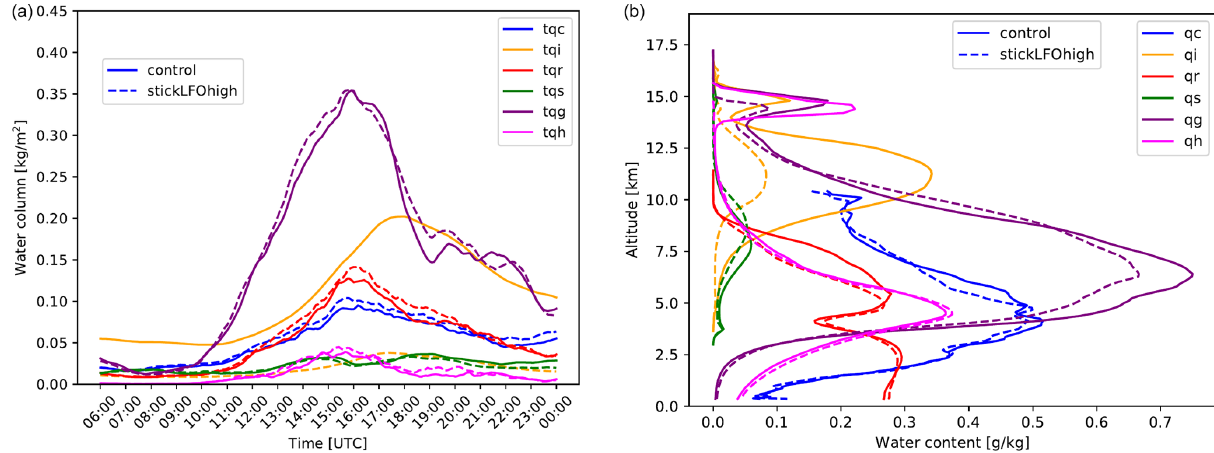
Figure 11. Similar to Fig. 10, but for high sticking efficiency (stickLFOhigh).